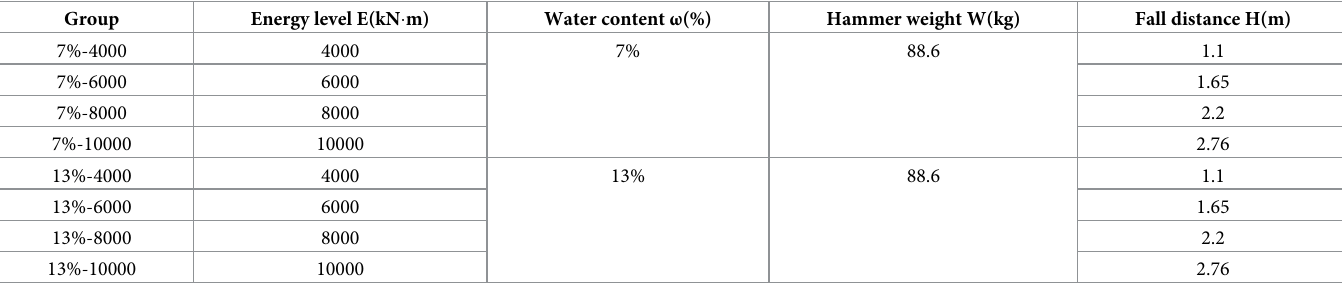
Table 3. Experimental scheme with different energy